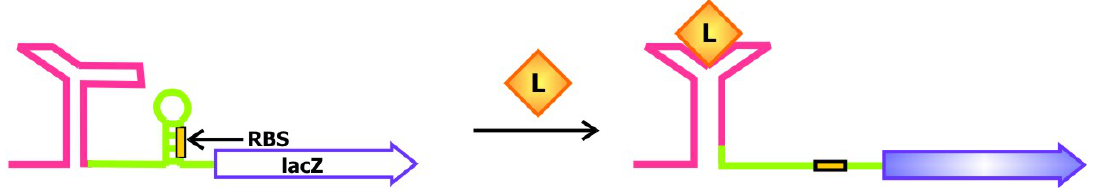
Figure 11. Design of a theophylline sensor based on the use of the artificial theophylline riboswitch, which regulates the translation of the lacZ reporter gene [19].